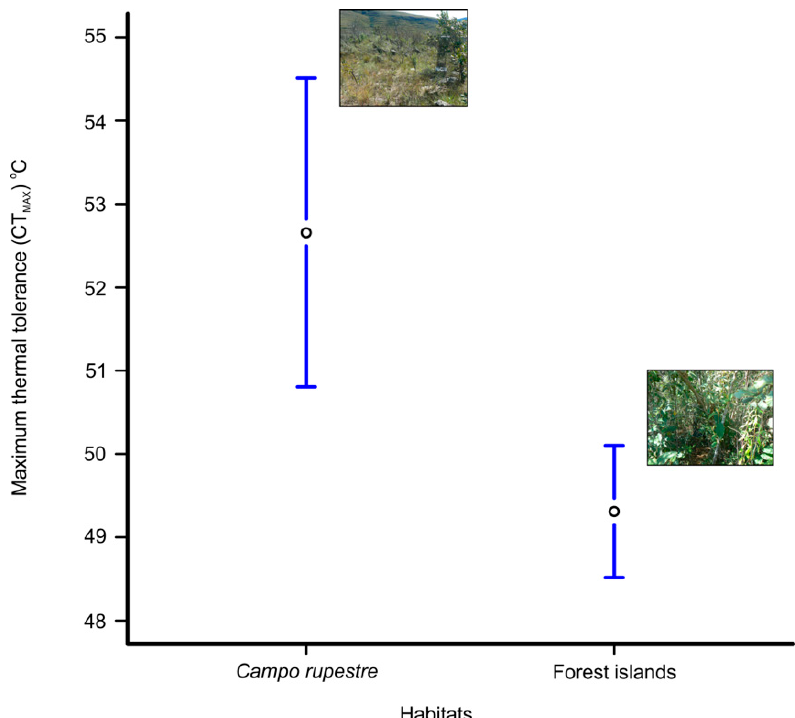
Figure 2. Mean of maximum critical temperature (CTmax) in °C per specimen of fruit-feeding butterflies sampled in the mountaintop environments. Species with higher thermal tolerances are shown in red. The bars represent 95% confidence interval.